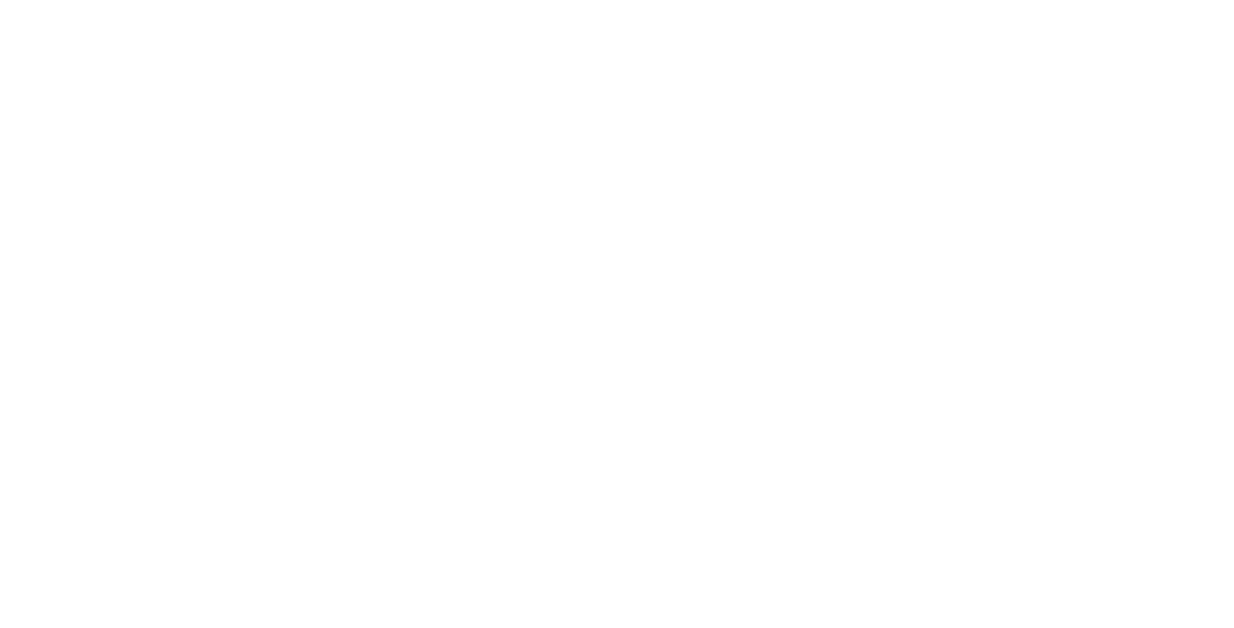
flagellated cells. ‡ Bipolar flagellated cells. ♢ Counterclockwise rotation of flagellar bundle. ♣ Clockwise rotation of flagellar